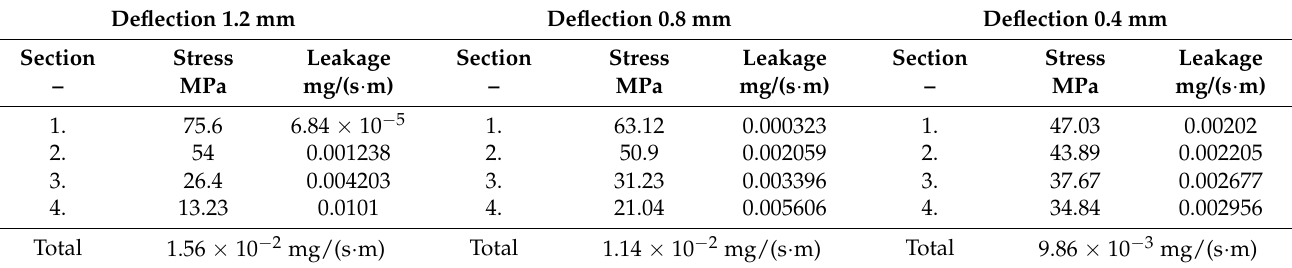
Table 5. Summary of calculated leakage